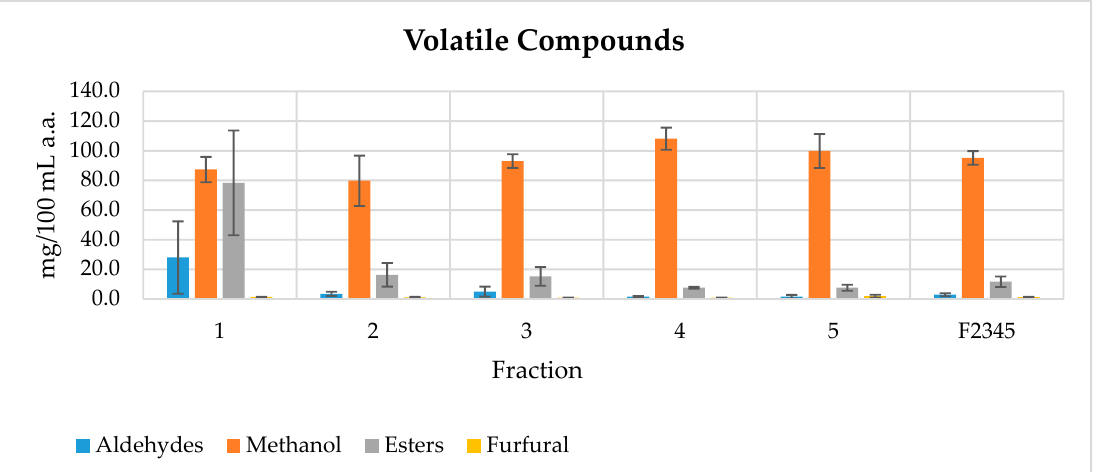
Figure 5. Concentration of methanol, esters, and furfural in di ff erent collected fractions.